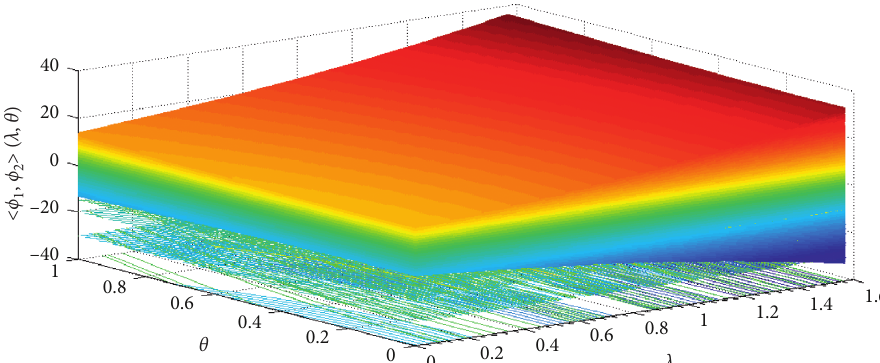
� (− 1 . 25 , 0 , 1 . 25 ; − 3 , 0 , 3 ) . 2